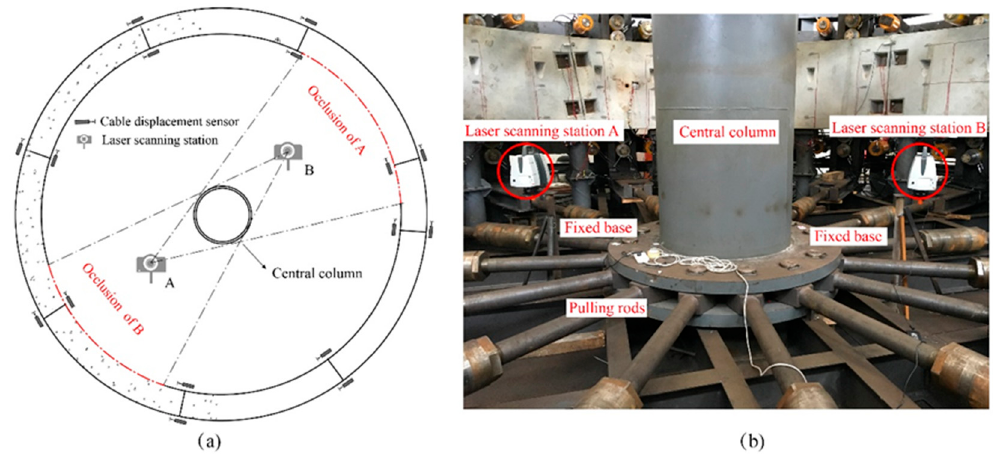
Figure 8. The schematic diagram and picture of the placement of the laser scanning stations: ( a ) schematic diagram (viewed from bottom to top); and ( b ) picture of the site.